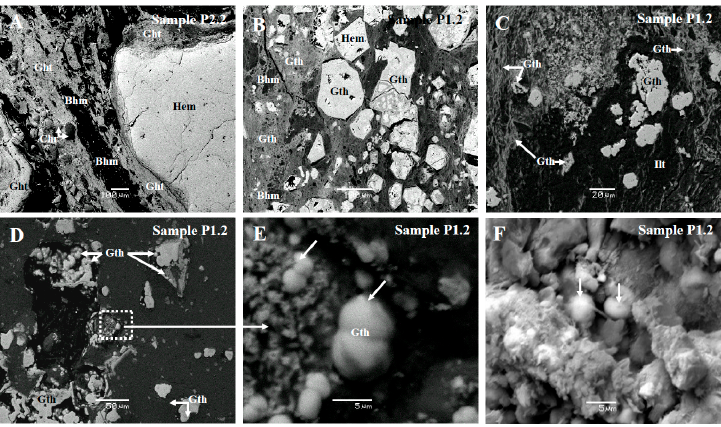
Figure 5. Representative back scattered images of bauxite laterite–Profile I showing: goethite (Gth) with varying composition (Table 4) and different morphological forms: rounded fragments, often martitized ( A , B ), Fe-(hydroxyl)-oxides pseudomorphs after pyrite ( B ). The unpolished parts of the sample revealed the presence of goethite micro-textures resembling bacterial cell coated by goethite (white arrows) ( C – F ).